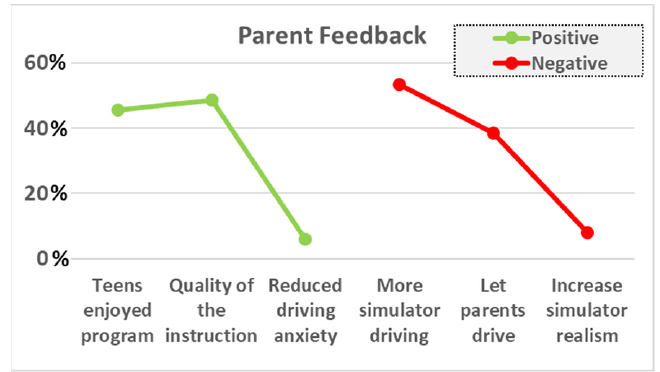
Figure 20. Parent Assessment Open-ended Summary.